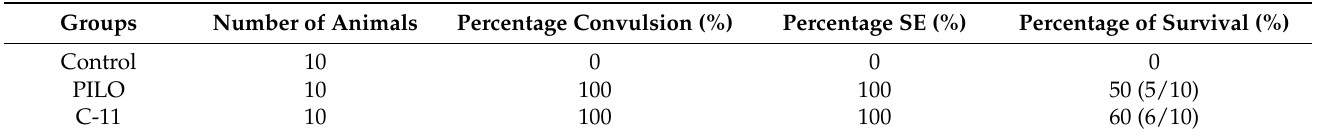
Table 3. Effect of C-11 on pilocarpine (PILO)-induced convulsions and lethality. Data on survivors and the number of animals with status epilepticus (SE) calculated as percentages. Groups Table 4. Drug-likeness parameters estimated according to Lipinski and Veber rules.